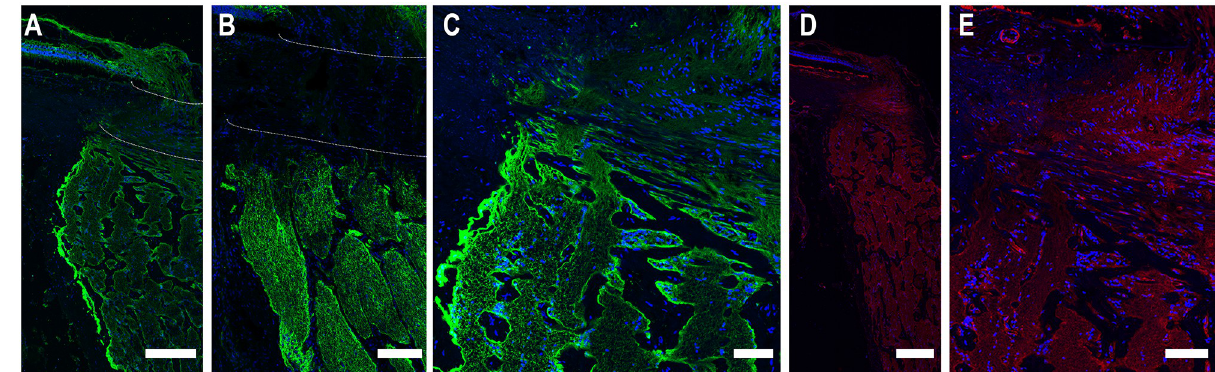
Fig 1. Longitudinal cryosections of immunolabeled aquaporin-4 and phalloidin on human (A-E), and porcine (B) optic nerve head tissue. Minimal label for AQP4 (green) is visible in the lamina cribrosa (between dotted white lines in A, B; seen at higher power in C and E. AQP4 label is prominent in the retinal nerve fiber layer, prelaminar area and myelinated optic nerve in each species. Phalloidin labeling of F-actin (red) is prominent in the prelamina, lamina and myelinated ON (D, E). AQP4 labeling is visible within axon bundles and pronounced along the edge of axons bundles and at the pia surface. DAPI (blue) identifies cell nuclei. Scale Bar: 200 μ m (A, D), 50 μ m (B, C, E).